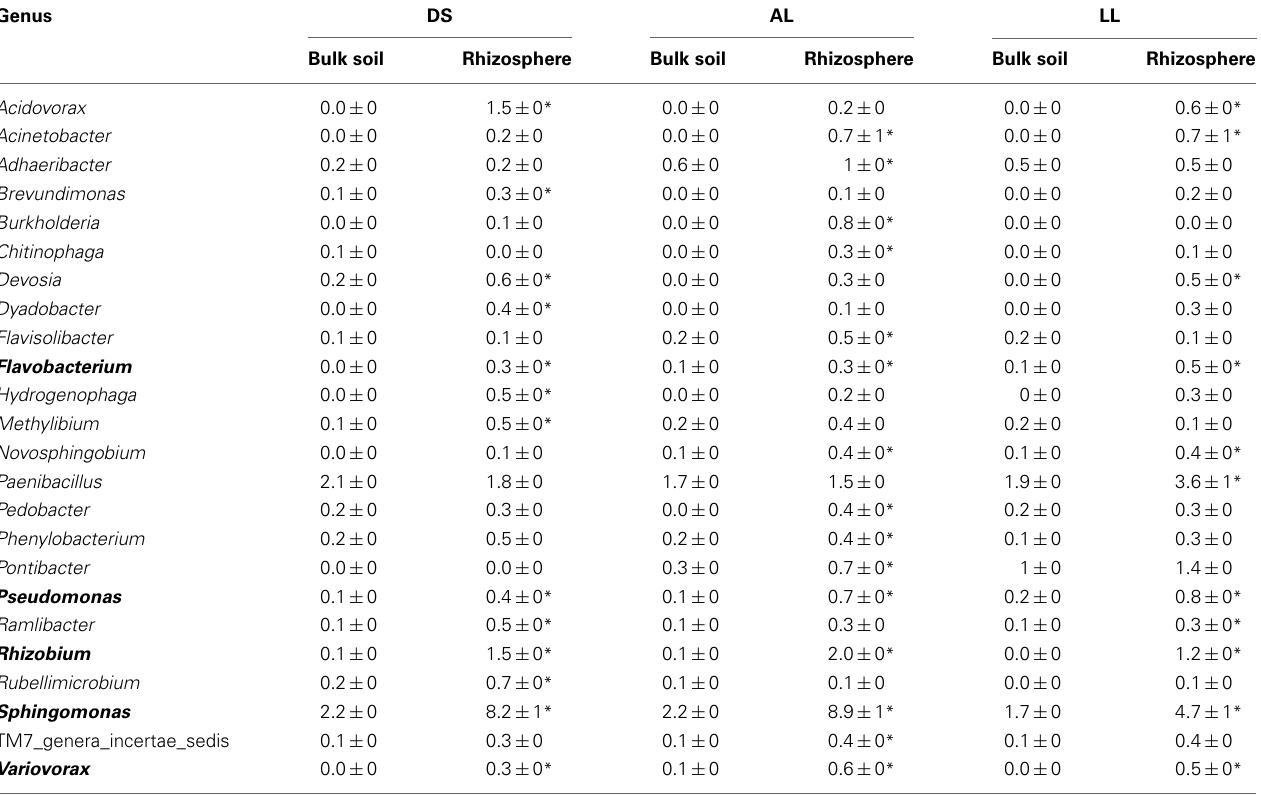
Table 3 | Enriched genera in the rhizosphere of lettuce 3 weeks after planting.